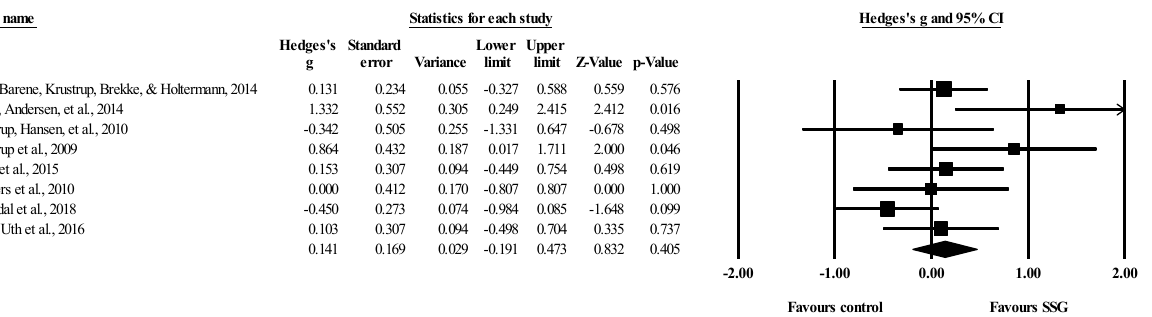
Figure 2. Forest plot of changes in total body bone mineral density in untrained adults after a training program based on soccer small-sided games (SSG) compared to a passive control condition. Values shown are effect sizes (Hedges’s g) with 95% confidence intervals (CI). The size of the plotted squares reflects the statistical weight of each study. The black diamond reflects the overall result.